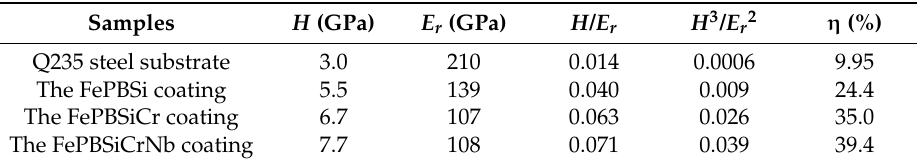
Figure 1. Load-unloading curves of the tested specimens. Table 1. Nano-mechanical properties of the samples.